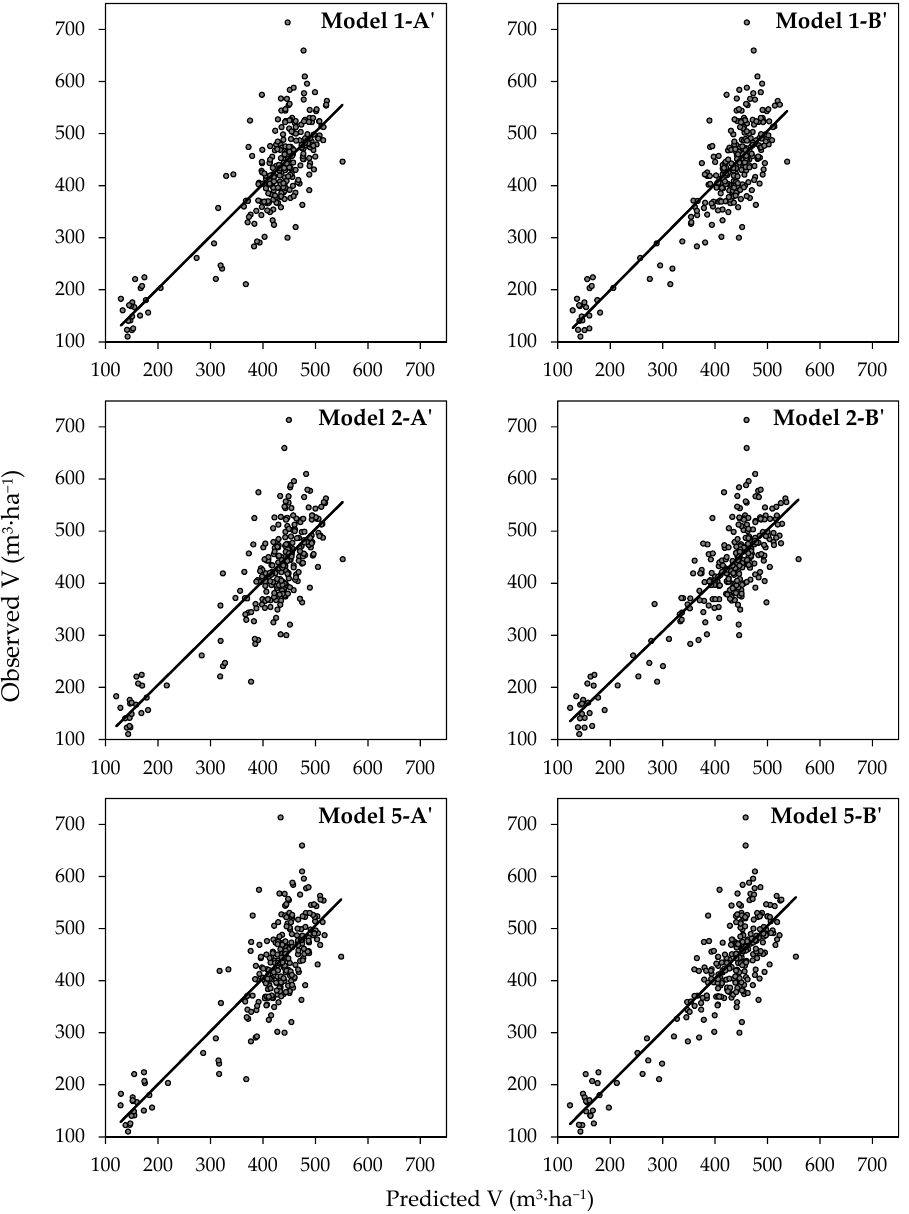
Figure A2. Observed vs. predicted stand volume (V) for six selected double-log volume models (validation dataset) described in Table A4. The solid line represents fitted linear model.